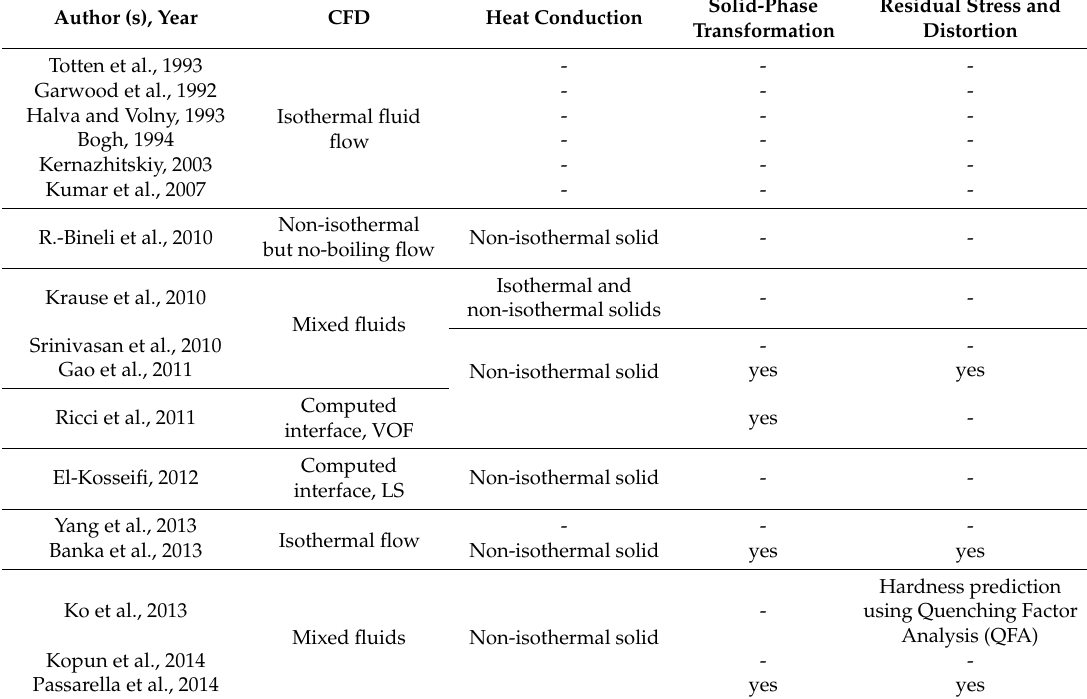
Table 1. Evolution of predictive power of mathematical models developed for metal